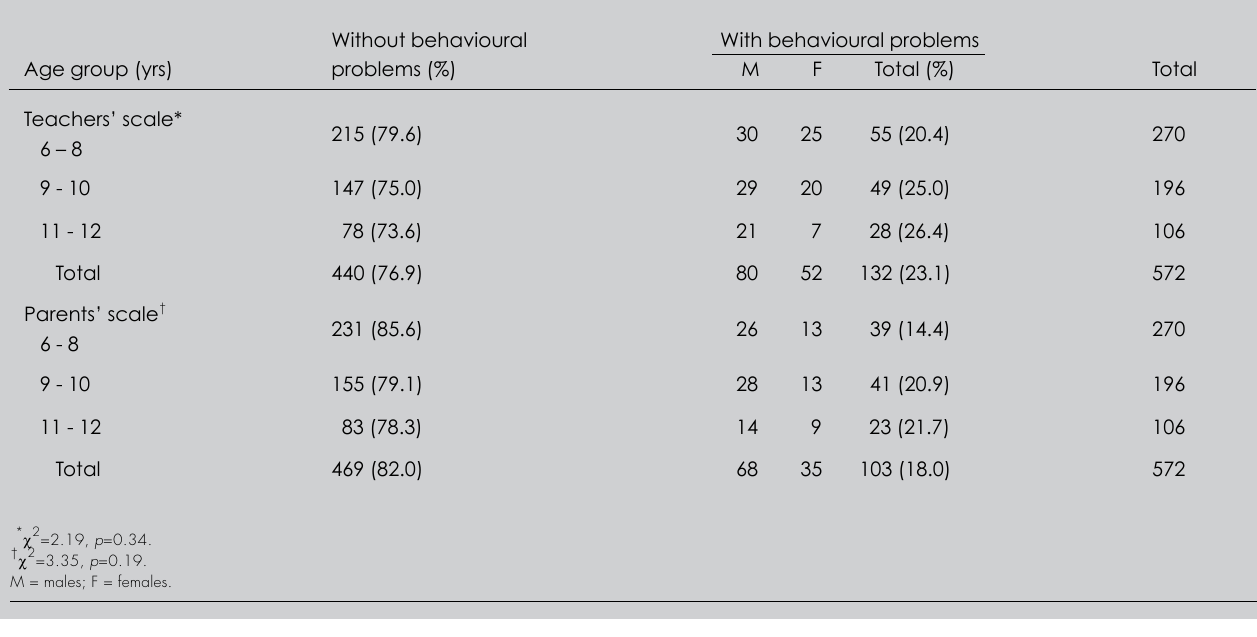
Table II. Gender distribution of children with behaviour problems on both scales according to age groups Without behavioural Age group (yrs) problems (%)